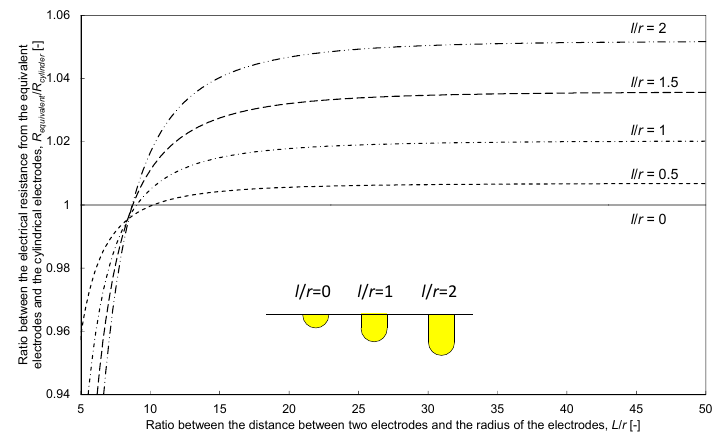
Appl. Sci. 2019 , 9 , 4167 Figure 7. Effect of l / r and L / r on the electrical resistance between two equivalent electrodes.